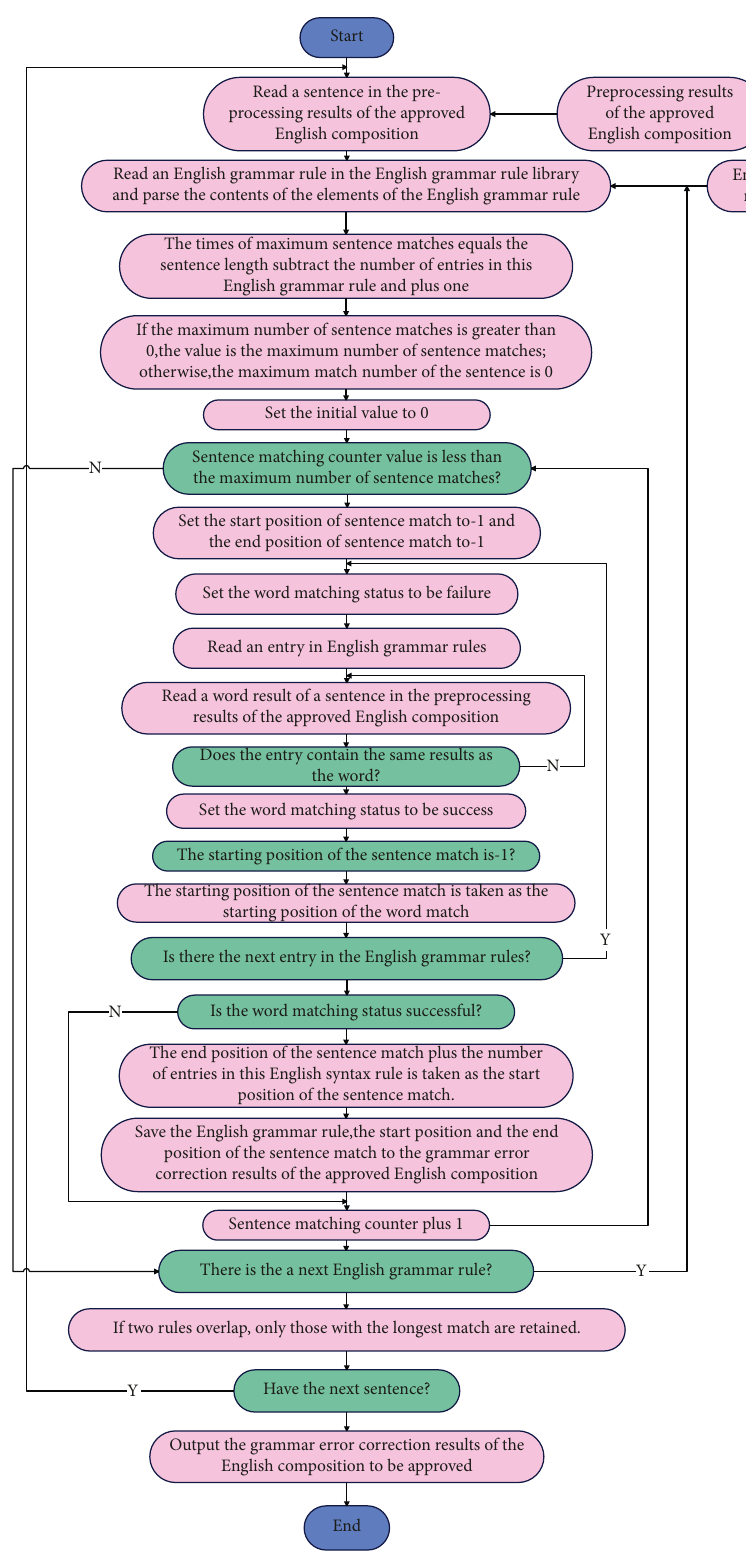
Figure 7: English writing correction model based on intelligent text semantic